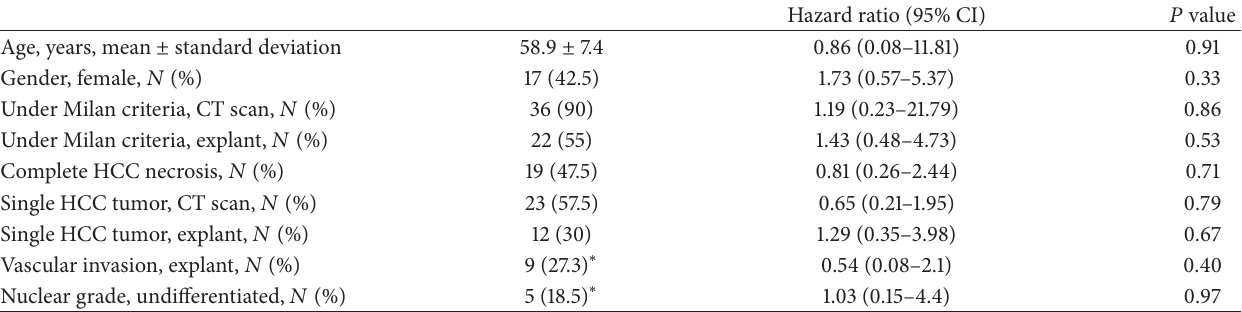
Table 1: Univariate Cox proportional hazards regression analysis for overall death.